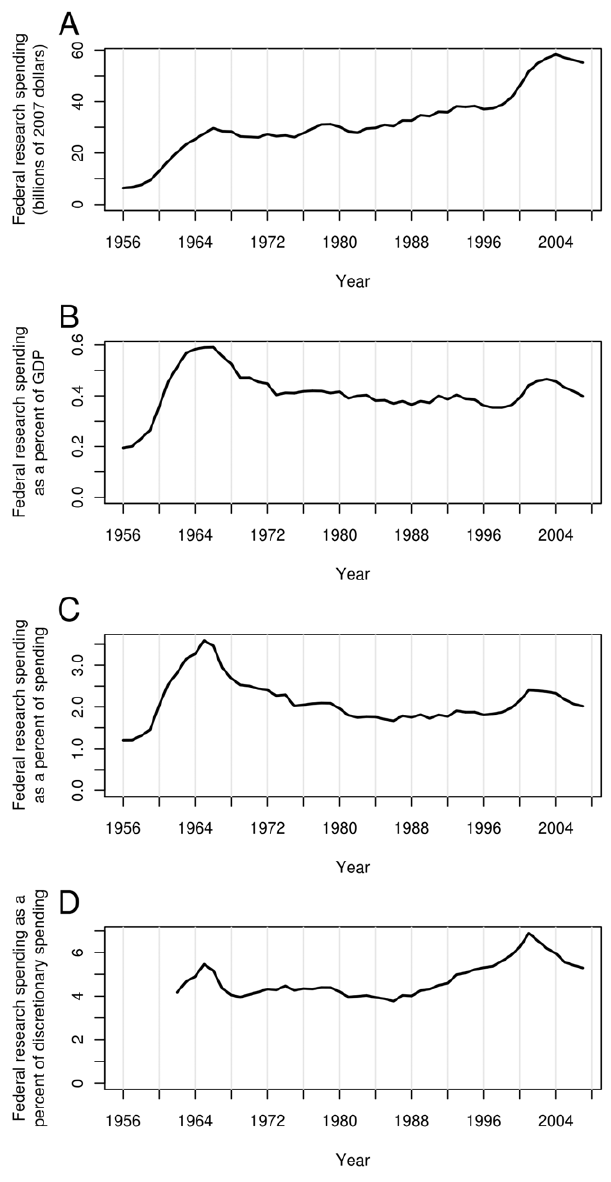
Figure 1. Federal research funding (FRF) in the United States of America (US) during the last six decades. FRF in constant dollars (A), as a percent of gross domestic product (GDP) (B), as a percent of federal spending (C), and as a percent of federal discretionary spending (D). Discretionary spending is money which is set aside each fiscal year by an annual spending bill on a non-mandatory